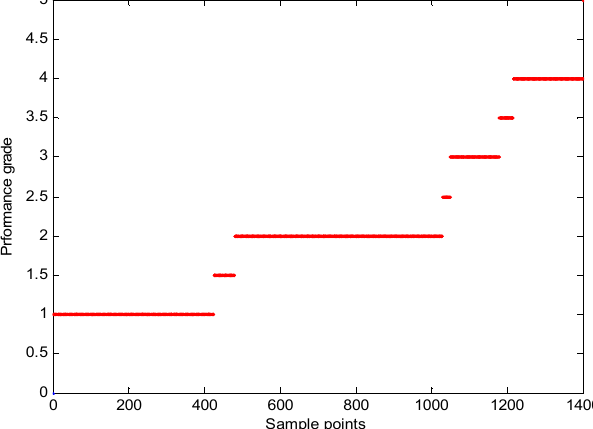
Figure 9. Online process performance assessment results.